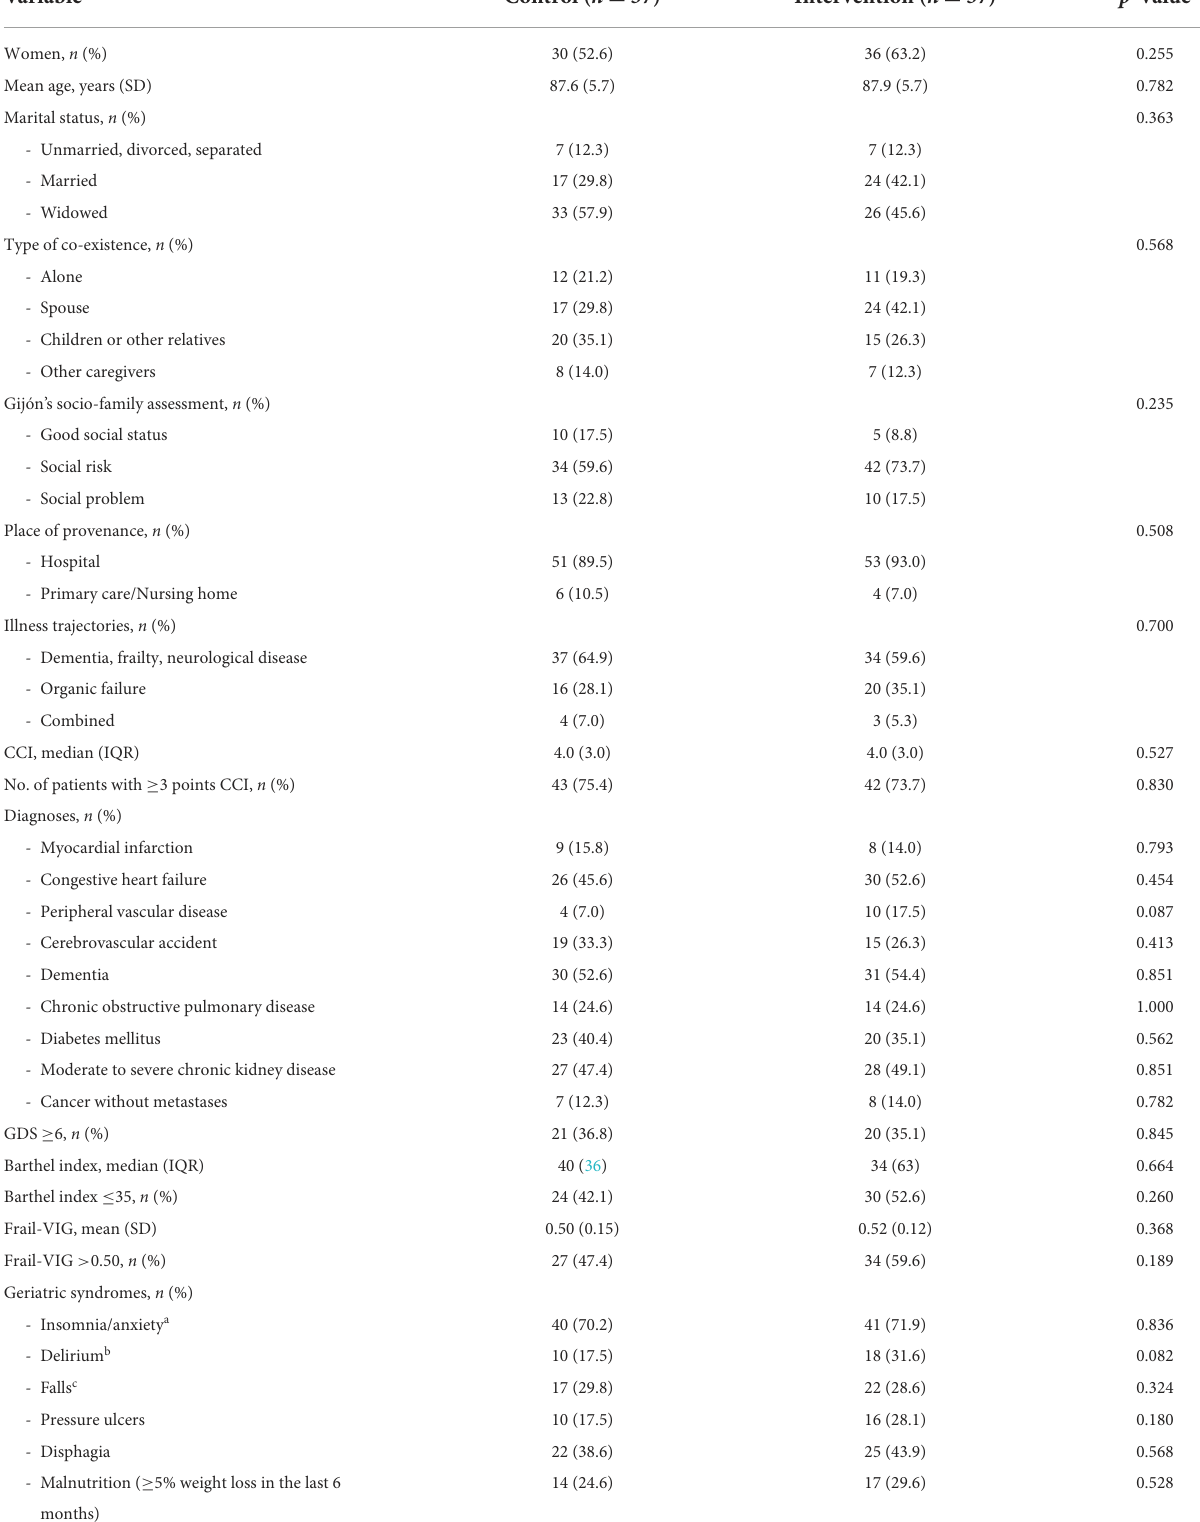
TABLE 1 Baseline characteristics of study